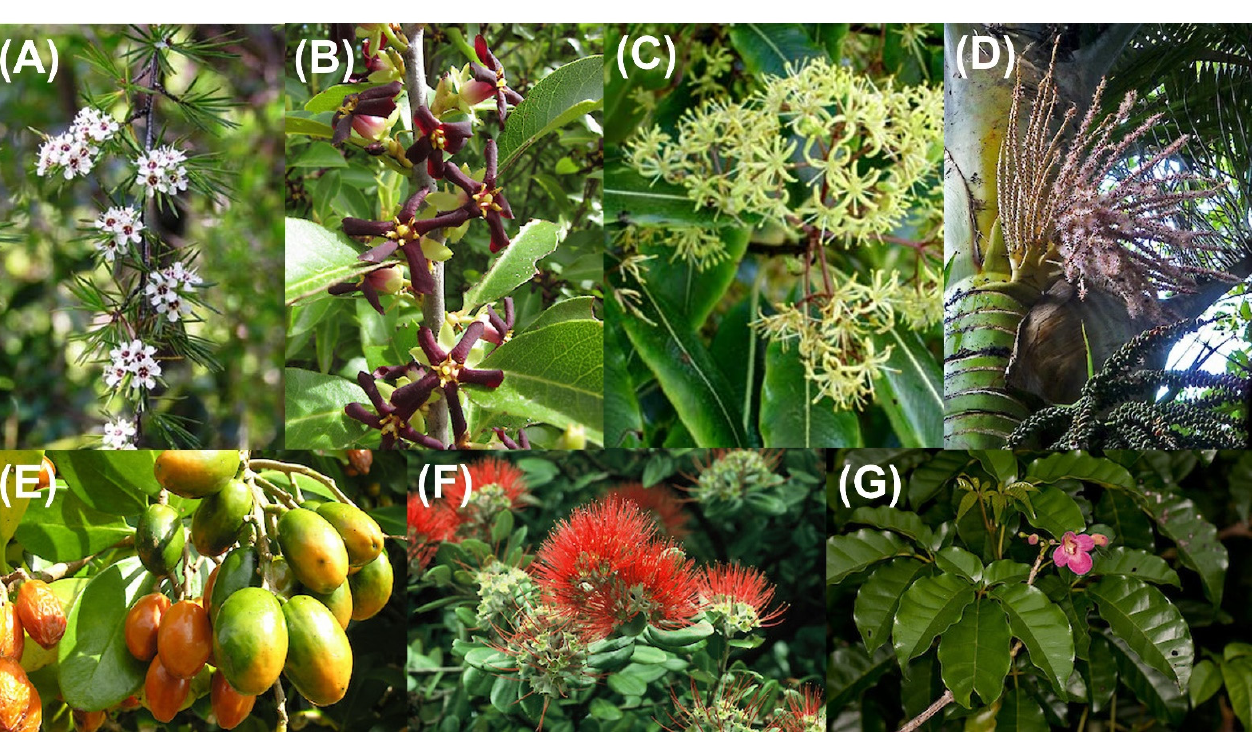
Figure A1. Sample pictures of New Zealand native trees grown and investigated environmental regulating services in domestic cities. ( A ) K ā nuka ( B ) K ō h ū h ū ( C ) Lemonwood (Tarata) ( D ) N ī kau ( E ) Karaka ( F ) P ō hutukawa ( G ) Puriri (Retrieved from New Zealand Plant Conservation Network (NZPCN), 2021). Image credit by Mike Wilcox (K ā nuka), John Barkla (K ō h ū h ū ), Peter J. de Lange (Lemonwood), Colin C. Ogle (N ī kau), Simon Walls (Karaka), Gillian M. Crowcroft (P ō hutukawa), and John E. Braggins (Puriri), CC BY 4.0 [147].